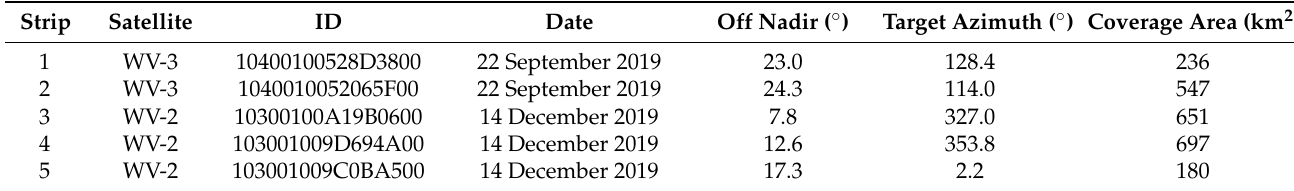
Table 1. Information of the WorldView-2 (WV-2) and -3 (WV-3) images acquired for this